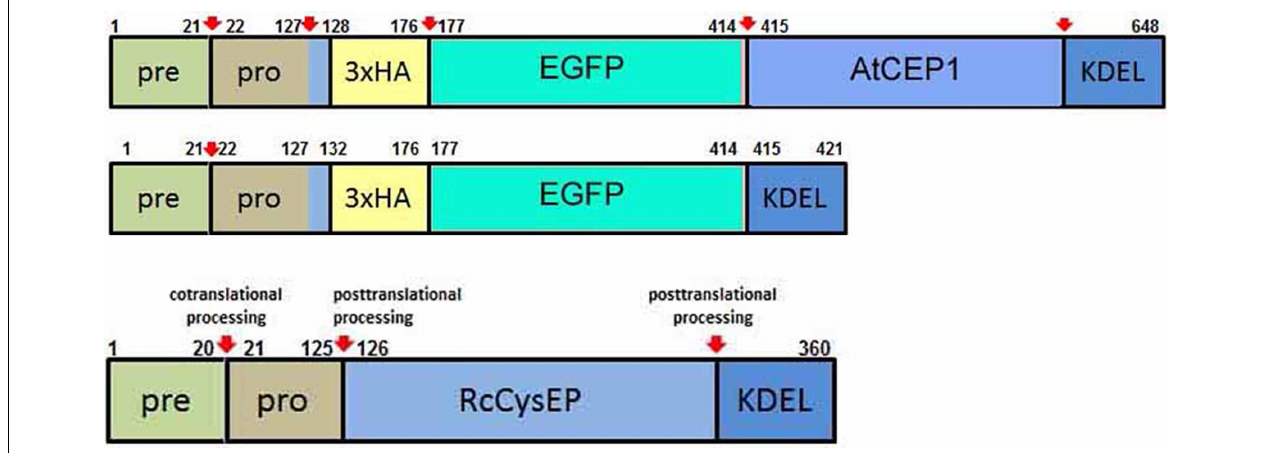
endogenous AtCEP1 promoter. Both constructs were transformed into atcep1 knock out mutant line SAIL_158_B06. Pre-pro-RcCysEP is shown for comparison. Red arrows indicate proven or predicted protein cleavage